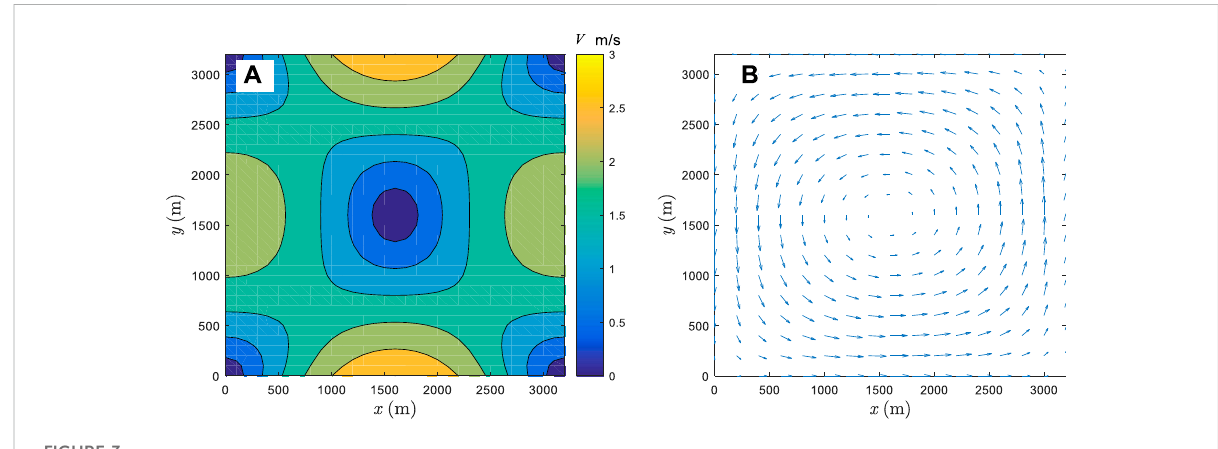
FIGURE 3 The absolute velocity (A) and velocity vector (B) for the large deformation fl ow.